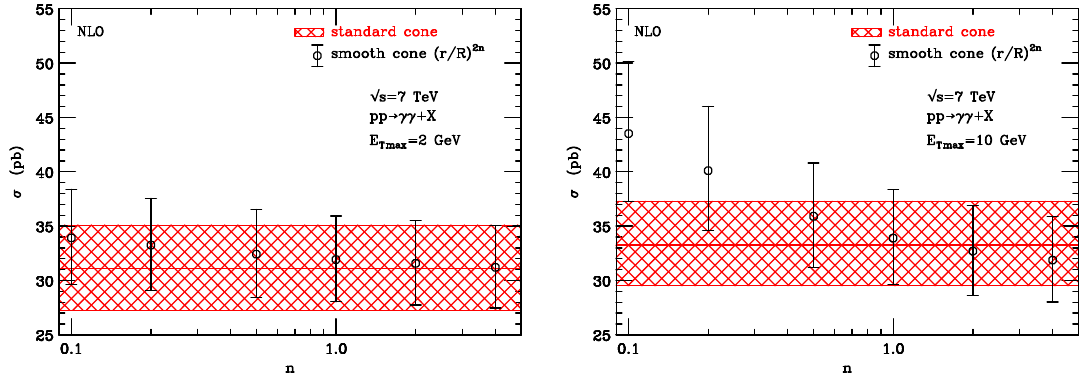
Figure 2 . Value of the NLO total cross section, including scale variation dependence, for the standard (red line and band) and smooth (black error bars) isolation criteria. The photon kine- matical cuts are described in the text (beginning of section 2.3). The results are obtained for two different values of E T max = 2 GeV (left panel) and 10 GeV (right panel). In the case of smooth cone isolation, some different values of the power n ( n = 0 . 1 , 0 . 2 , 0 . 5 , 1 , 2 , 4) in the isolation function χ ( r ; R ) = ( r/R ) 2 n are